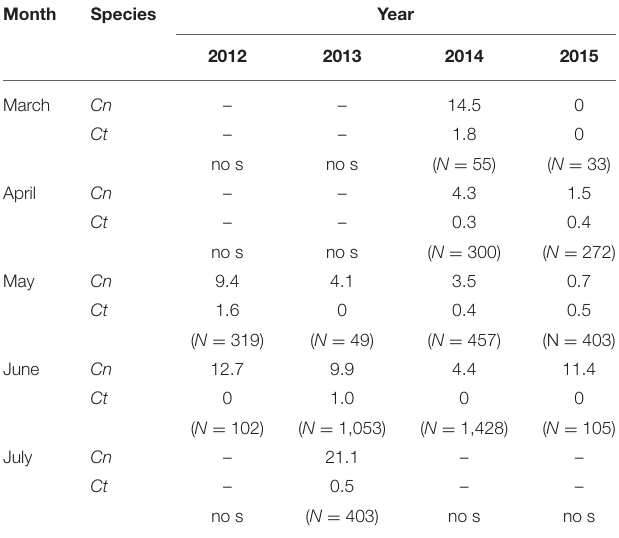
C. transversoguttuta ( Ct ) (vs. the third and most abundant Coccinella species present, C. septempunctata ), as encountered in combined visual searches for the two sites by month for individual